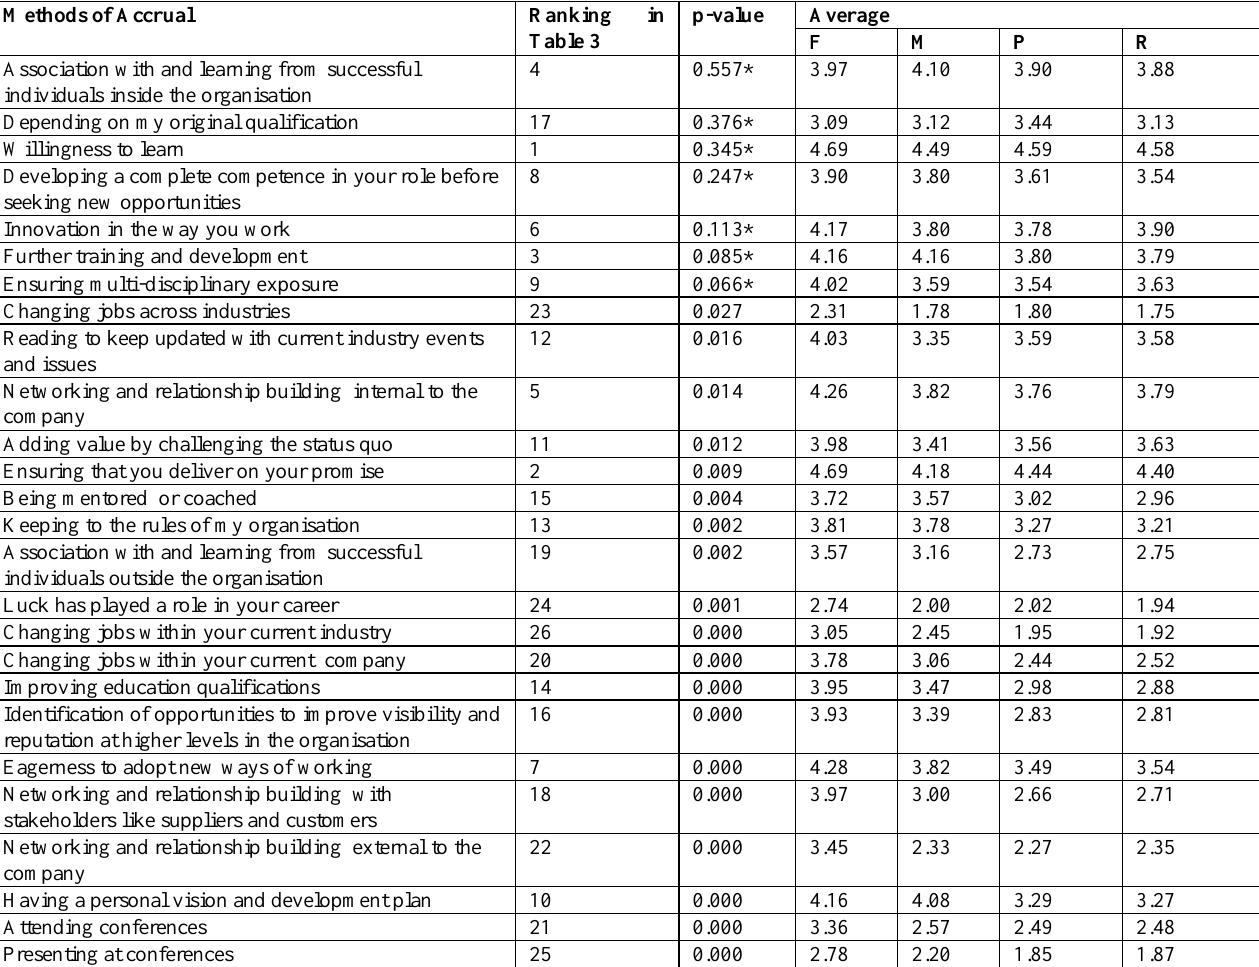
Table 6: Comparison of methods of acquiring career capital across the 4 sectors Methods of Accrual Ranking in